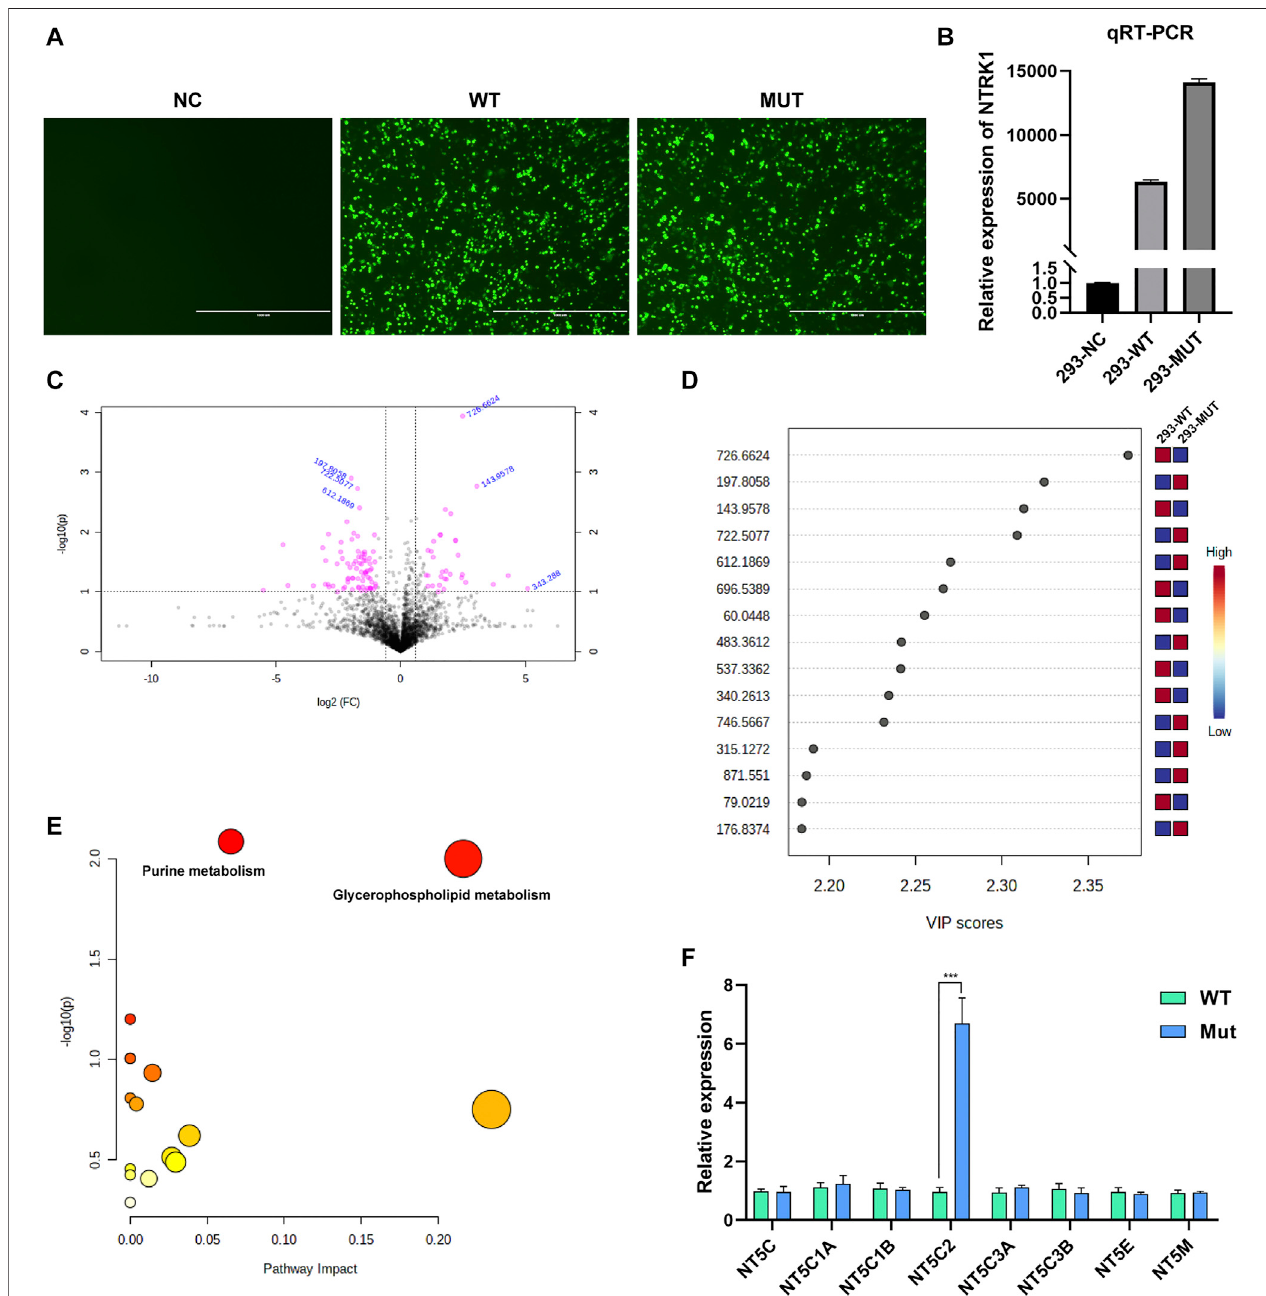
FIGURE 4 | Results of in vitro study. (A) The GFP fl uorescent signal at 48 h after transfection. NC, no vector; WT, with wild-type MFN2 cDNA plasmid; MUT, with MFN2: c.638T > C mutant cDNA plasmid. Scale bar, 1000 μ m; magni fi cation, × 100. (B) The relative NTRK1 mRNA levels in three cell groups. (C) The volcano plot showing signi fi cantly different compounds. Red dots represent the compounds with difference > 2.0 folds and p < 0.05, blue font represents the m/z molecular weight information. (D) Partofthecompoundswithvip(variableimportanceinprojection)value > 1.TheX-andY-axesstandforvipscoreandm/z,respectively. (E) KEGG pathway enrichment result. Each point represents a pathway, with X- and Y-axes indicating the importance of a compound related to the pathway and-log10(P) value, respectively. (F) The relative mRNA levels of various enzymes that can catalyze the hydrolysis of the AMP in WT and Mutant transfected cell groups.